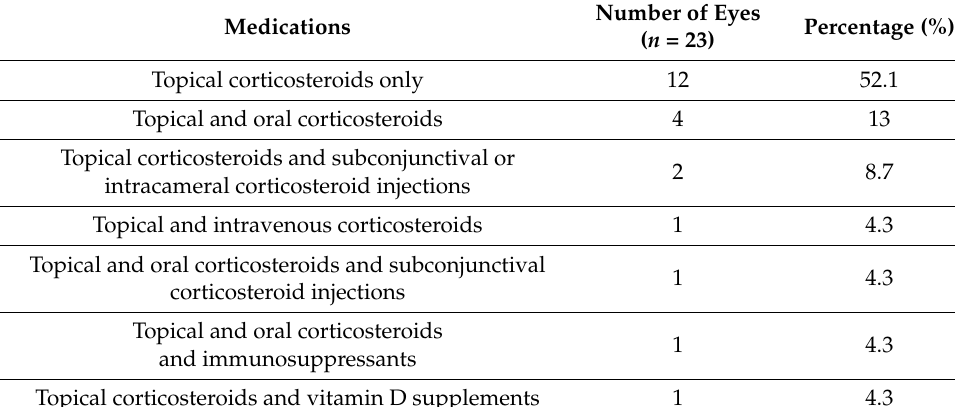
Table 5. Medications used for corneal graft